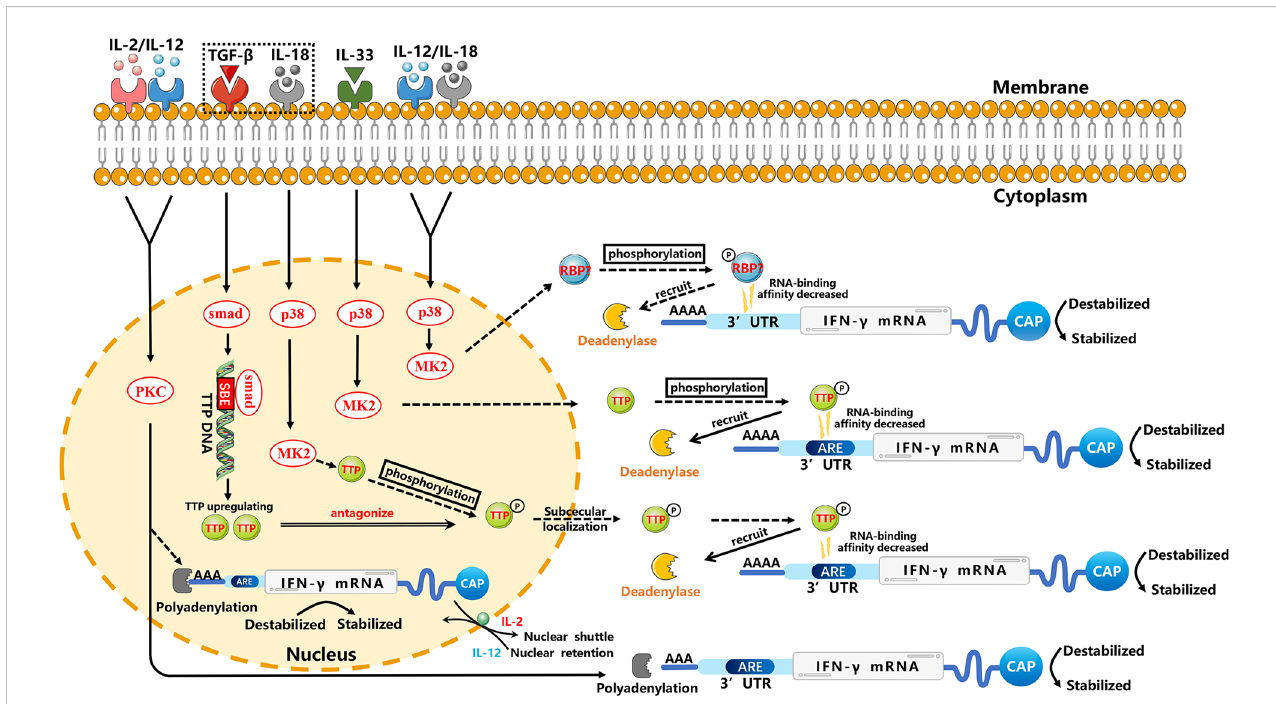
FIGURE 1 Regulation of the stability of IFN- g mRNA in NK cells through p38 MAPK and PKC signal-transduction pathways. For clarity, these posttranscriptional regulators are not necessarily placed at the correct cell site. IL-12 and IL-18 can enhance the stability of IFN- g mRNA in NK cells through the p38 MAPK pathway, which may phosphorylate unknown RBPs to result in decreased RNA-binding af fi nity and then decreased deadenylation. TGF- b inhibits the stability of IL-18-induced IFN- g mRNA. IL-18 may inhibit TTP mRNA and affect the stability of IFN- g mRNA through the p38 MAPK pathway, which may phosphorylate TTP. This phosphorylation results in the decreased RNA-binding af fi nity of TTP, which can trigger deadenylation of IFN- g mRNA by recruiting cytoplasmic deadenylase. However, TGF- b can upregulate TTP transcription speci fi cally through the Smad pathway. Smad proteins downstream of TGF- b receptors can mediate a stimulatory effect by binding the SBE of the TTP promoter (45), thereby repressing expression of IL-18- induced IFN- g mRNA through TTP-induced destabilization. A similar TTP-related mechanism may be found in IL-33-stimulated NK cells. IL-2 and IL-12 may affect the stability of cytoplasmic IFN- g mRNA and stability of the nuclear-processed form of IFN- g mRNA through PKC-dependent polyadenylation in NK cells. In addition, IL-12 mediates nuclear shuttling whereas IL-2 mediates nuclear retention, which may be related to AREs, but the speci fi c mechanism requires further investigation. Solid arrows indicate con fi rmed mechanisms. Dashed arrows indicate possible mechanisms that need further veri fi cation. Molecular interactions and all abbreviations are explained in the